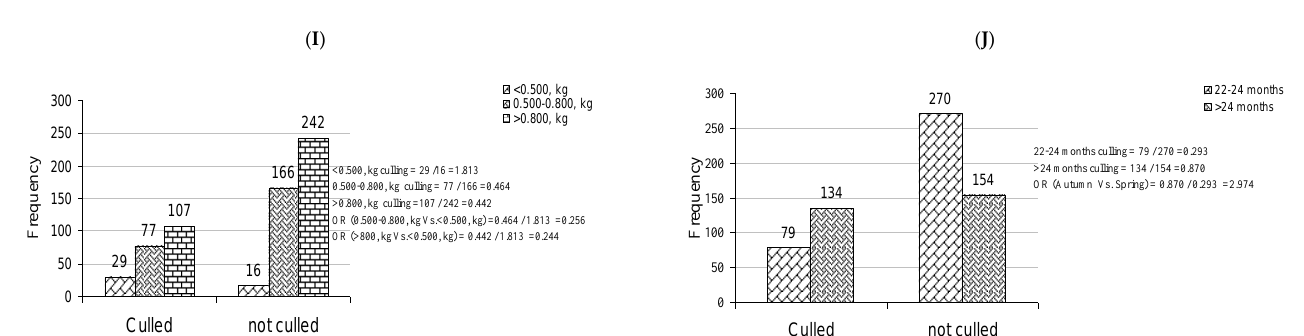
Figure 2. Relationships between culling risk in primiparous goats and birth season ( A ), kidding season ( B ), birth weight ( C ), total litter size ( D ), numbers of kids dead ( E ), numbers of kids weaned ( F ), total milk yield ( G ), length of lactation ( H ), average daily milk yield ( I ), and age at first kidding ( J ).